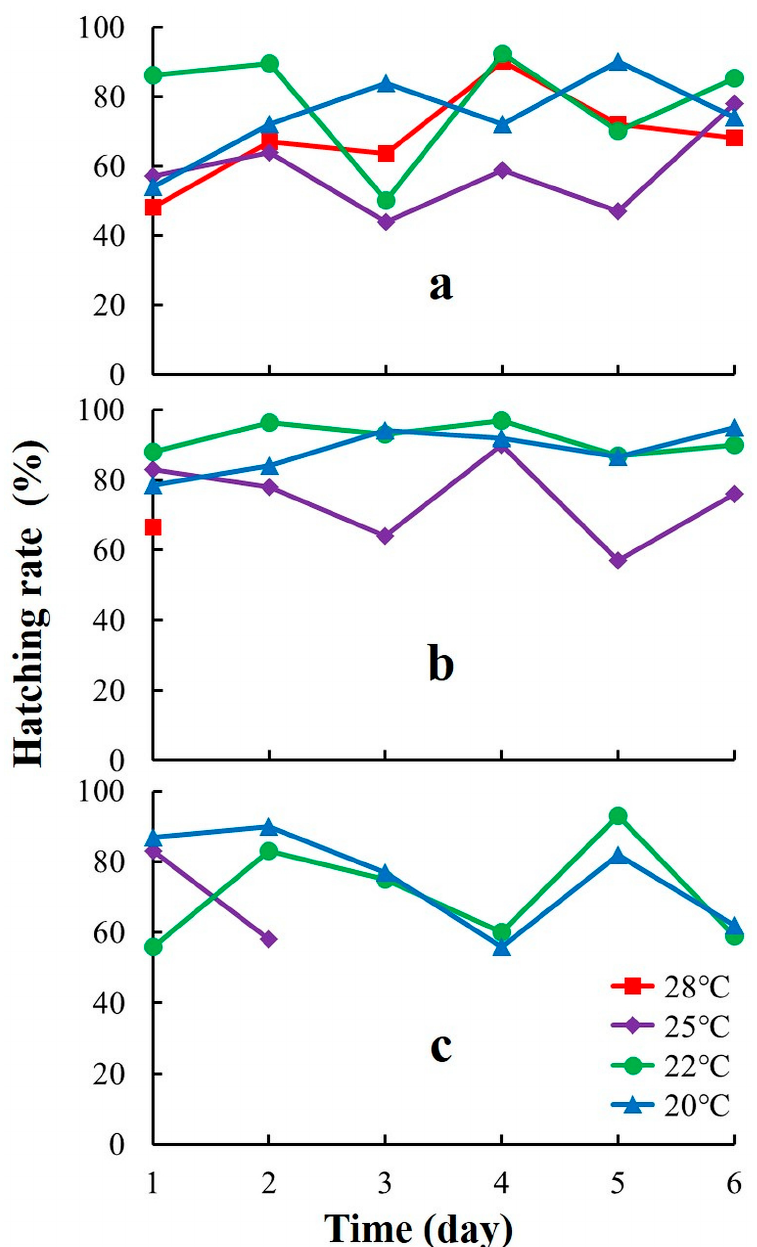
Figure 5. Hatching rates of Acartia bifilosa eggs which were produced under different seawater temperatures (20, 22, 25, and 28 °C) and Chl a concentrations ( a ): 15 μ g/L, ( b ): 10 μ g/L, ( c ): 5 μ g/L).